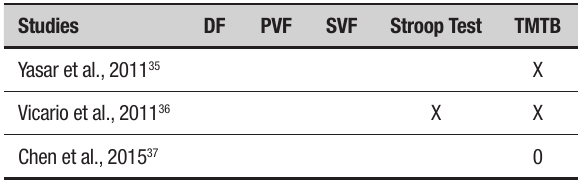
Table 6. Summary of impaired tests among patients with SAH in longitudinal